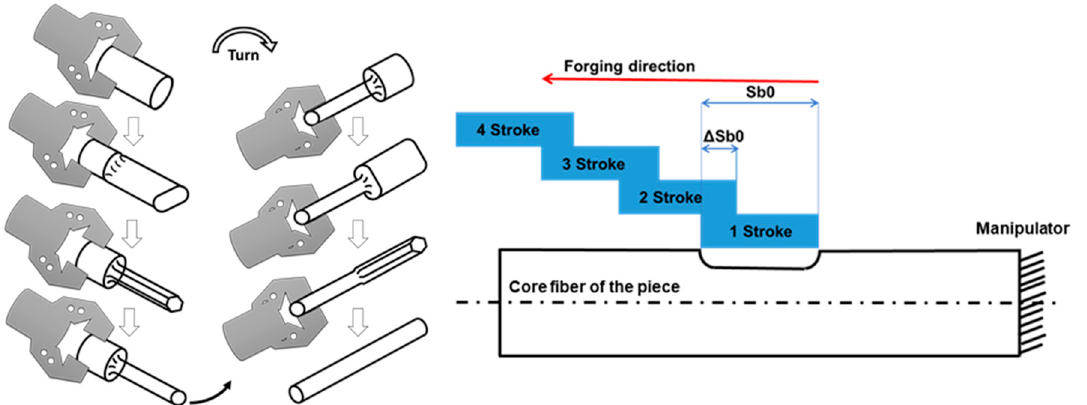
Figure 1. Schematic representation of the simulated forging process.